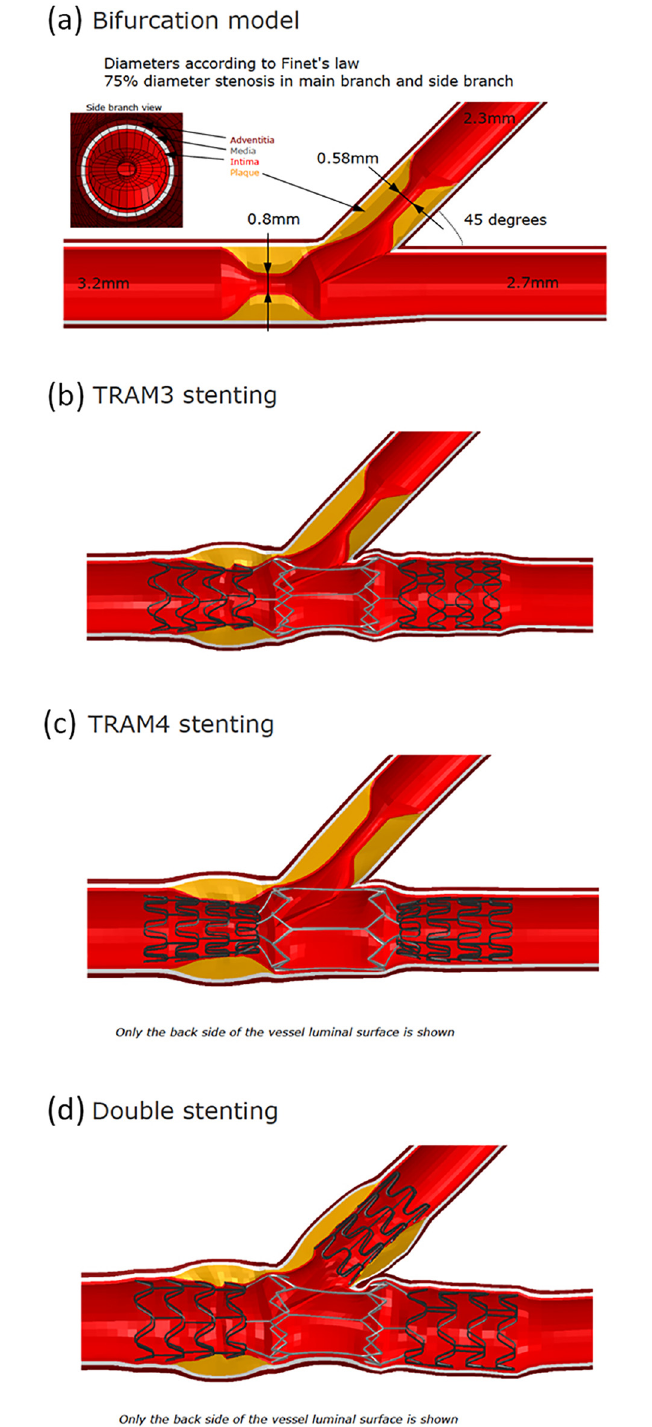
Fig 4. Stage 2 of the study which shows (a) the bifurcation model with the lesion (b) the disposition of the deployed stent with 3 connecting links (c) the disposition of the deployed stent with 4 connecting links (d) Double stenting